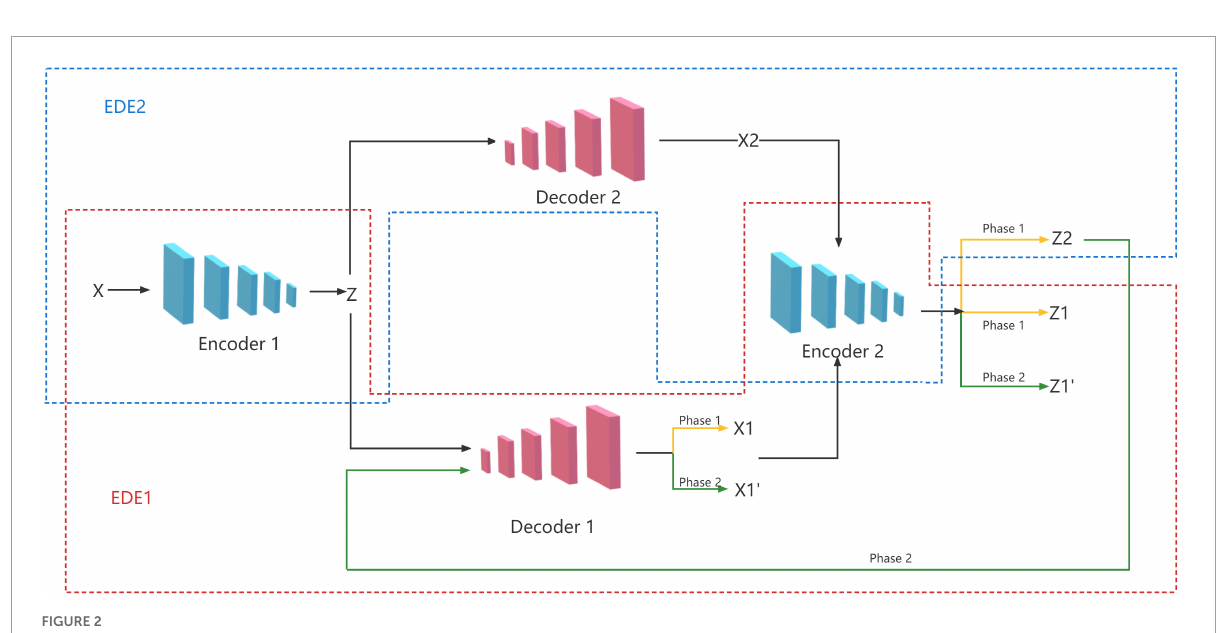
FIGURE2 Proposed architecture illustrating the information